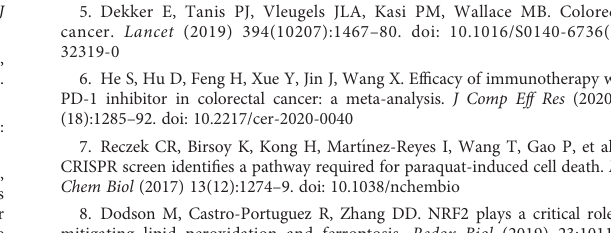
SUPPLEMENTARY TABLE 1 Primer sequences for PCR ampli fi